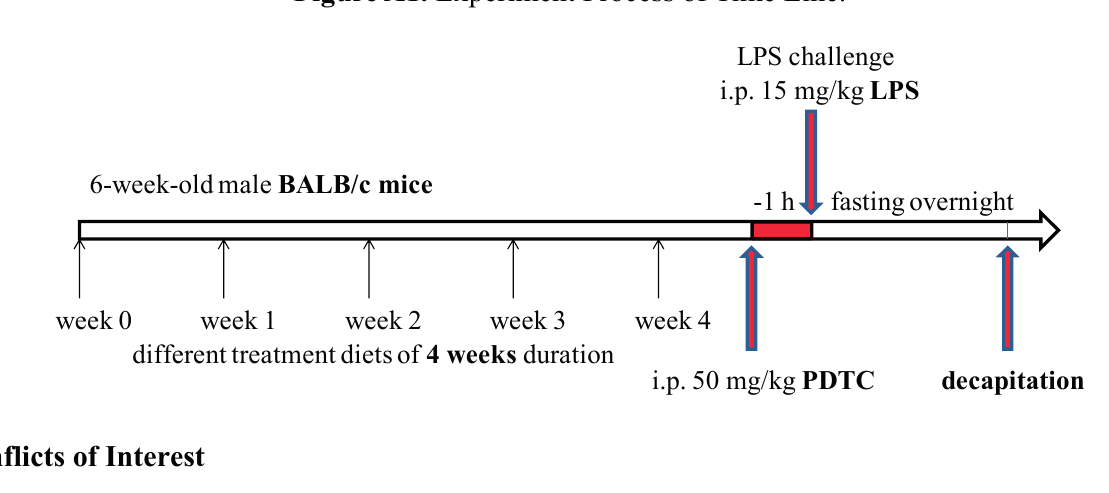
Figure A1. Experiment Process of Time